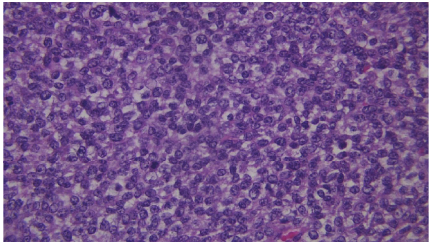
Figure 4: The tumor is hypercellular and mitotically